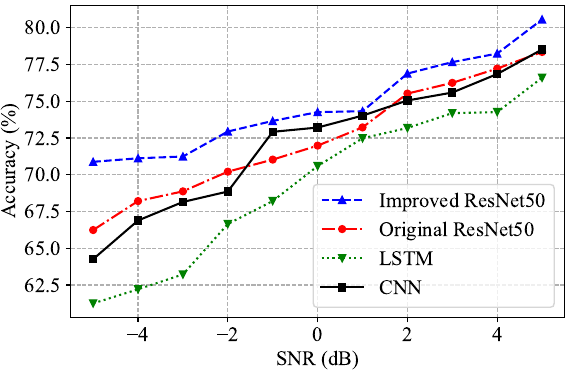
Figure 17. Test accuracies of four methods under noisy